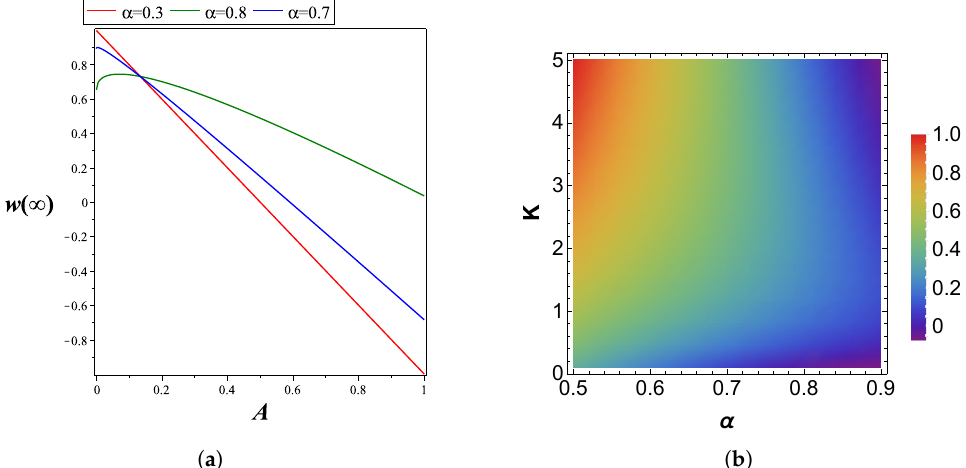
Figure 4. ( a ) Atomic population inversion left at the steady state in terms of the initial populations < α < 1; ( b ) atomic population inversion left at the steady state in terms of for A 1 = 1, K = 1 and 1 5 the shape factor α and the deformation factor K, where A =